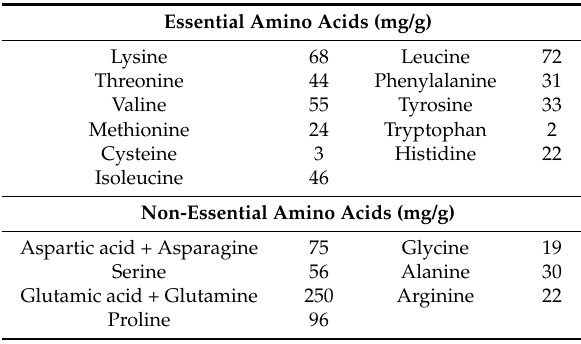
Table 1. Amino acid composition of casein